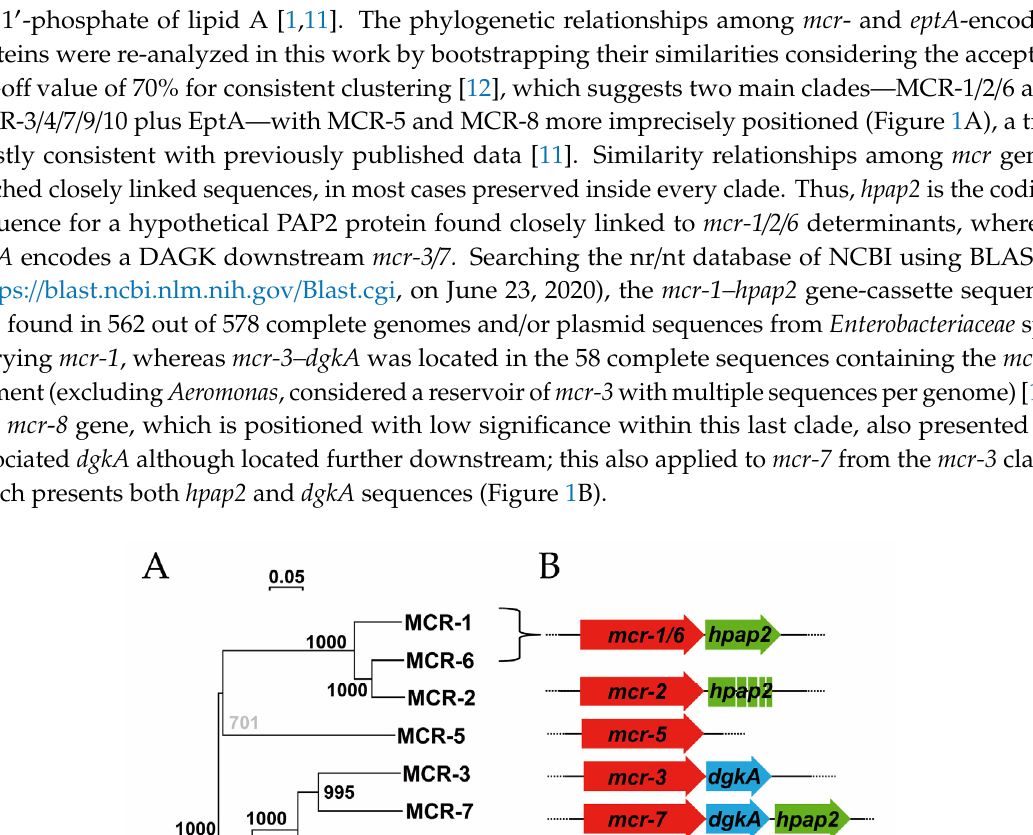
transferases to outer regions of lipopolysaccharide (LPS), included as outlier sequences. All sequences shown are from Escherichia coli except for MCR-6 ( Moraxella sp.), MCR-7, MCR-8, MCR-9, and EptA-Kpn ( Klebsiellapneumoniae ) and EptA-Sen ( Salmonella enterica ). ( B ) Genetic organizations shown were deduced from the environments of mcr / eptA ( pmrC ) genes encoding the above-mentioned